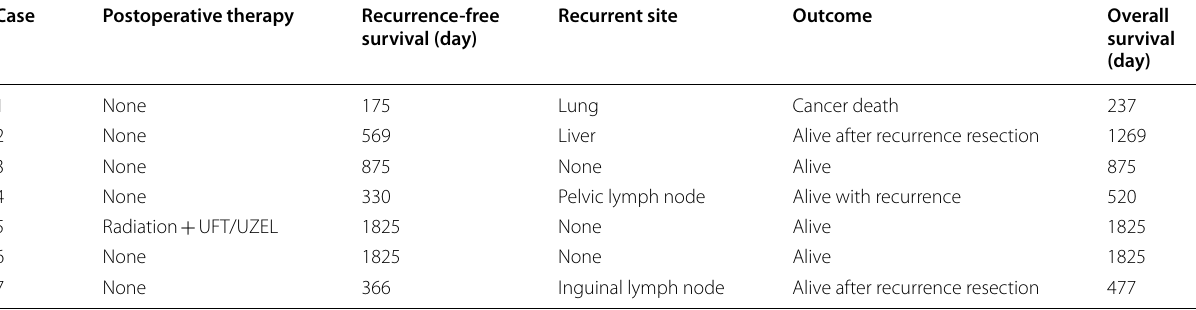
Table 3 Prognosis of seven patients with cancer associated with anal fistula Case Postoperative